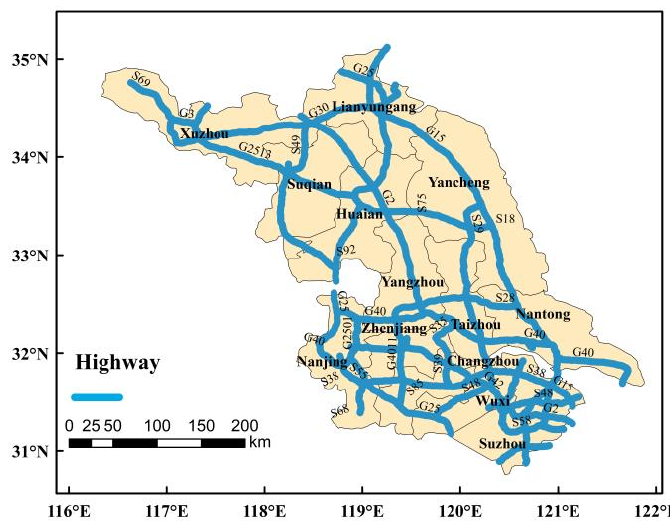
Figure 1. Distribution of highway networks in Jiangsu Province.